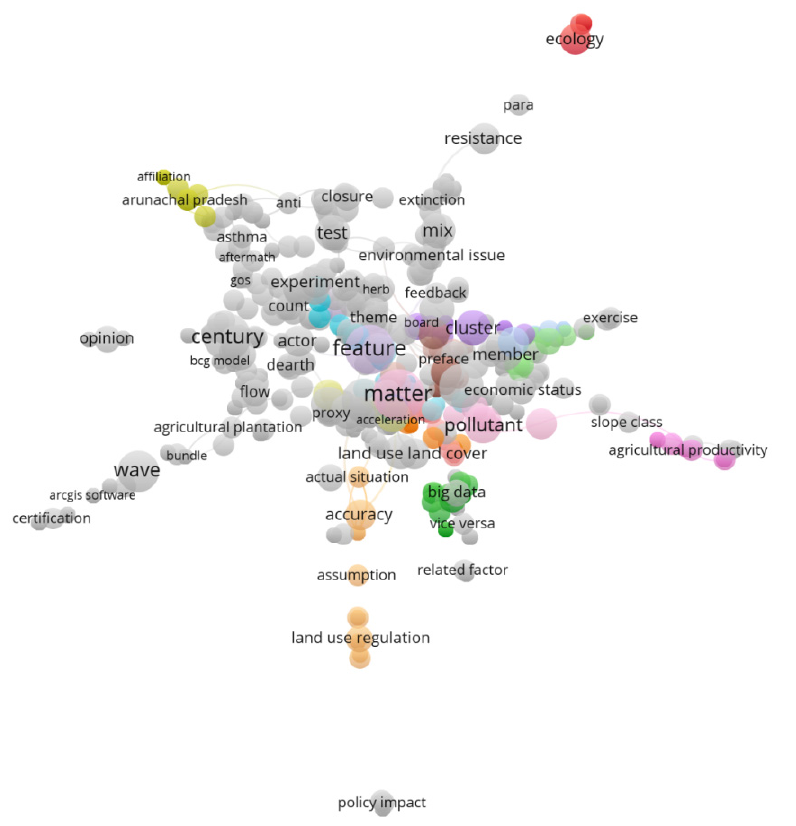
Figure 5. Network visualization map constructed from text data, considering terms as items, for the topics “COVID-19” and “land use”, applying binary counting with 1 as the minimum number of occurrence of a term. Table 1. Top 20 terms with the highest occurrences found in text data for the topics “COVID-19” and “land use”, applying binary counting with 1 as the minimum number of occurrence of a term.